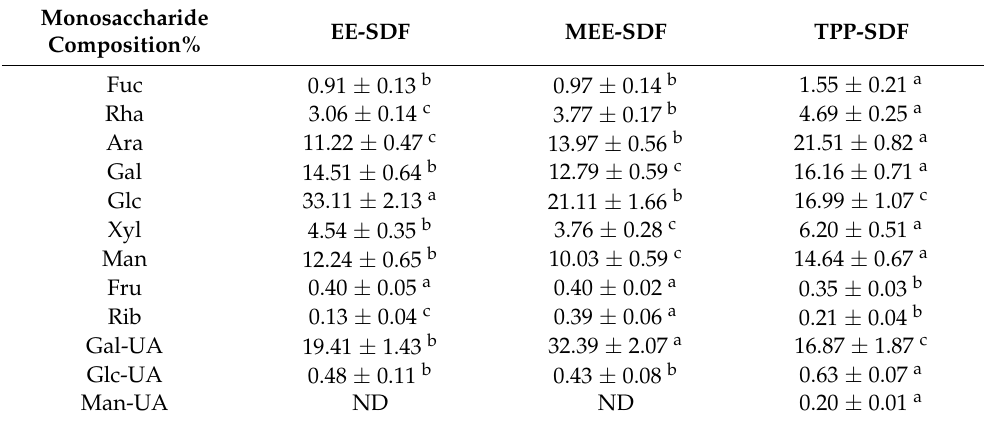
Table 2. Monosaccharide composition of soluble dietary fiber by different extraction methods. Monosaccharide Composition%